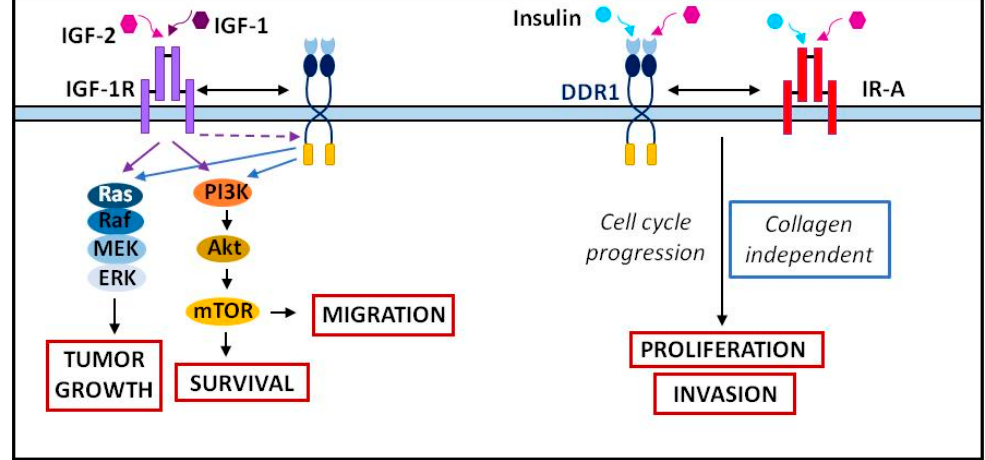
Figure 5. Crosstalk between DDR1 and the IGFs/insulin receptors. Adapted from [132,138].